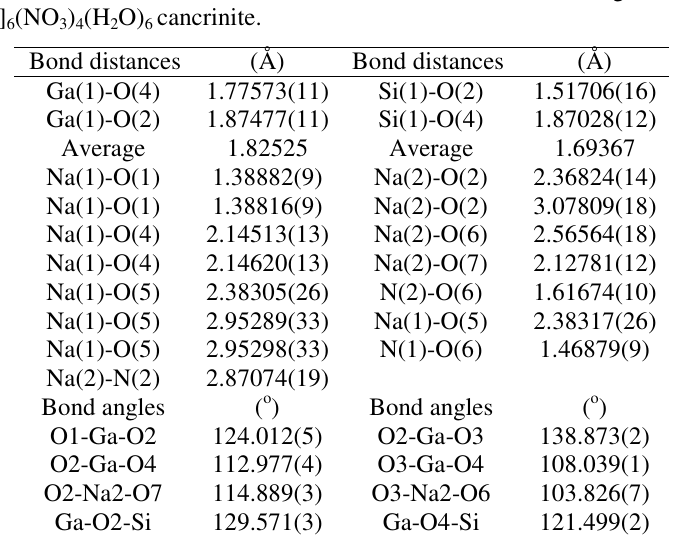
Table 3. Selected derived bond distances and bond angles for